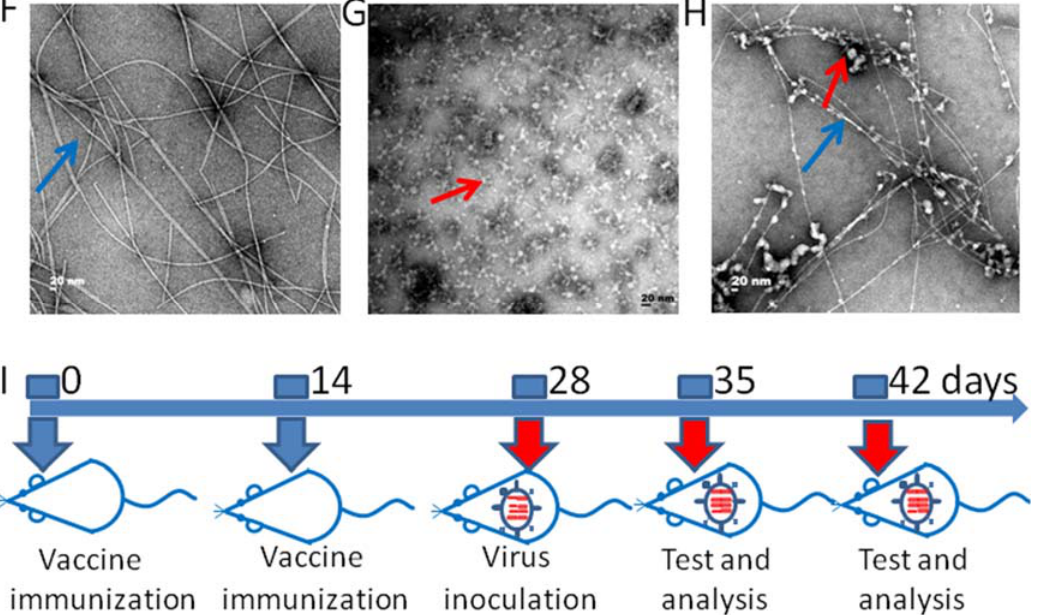
Figure 1. The microstructure of the adjuvant vaccine and the schematic illustration of immunization procedure. ( A ) The molecular structure of Npx ‐ G D F D F D Y (D conformation). ( B ) The molecular structure of Npx ‐ G L F L F L Y (L conformation). ( C ) Transmission electron microscopy (TEM) photomicrographs of the D ‐ Tetra ‐ Peptide Hydrogel. ( D ) TEM photomicrographs of the H7N9 antigen. ( E ) TEM photomicrographs of the mixture of D ‐ Tetra ‐ Peptide Hydrogel and vaccine. ( F ) TEM photomicrographs of the L ‐ Tetra ‐ Peptide Hydrogel. ( G ) TEM photomicrographs of the H7N9 antigen. ( H ) TEM photomicrographs of the mixture of L ‐ Tetra ‐ Peptide Hydrogel and vaccine. ( I ) Schematic illustration of immunization procedure. Six mice in each group were immunized for further evaluation. The representative morphology of the vaccine antigen is indicated with a red arrow and the representative morphology of the hydrogel is indicated with a blue arrow.